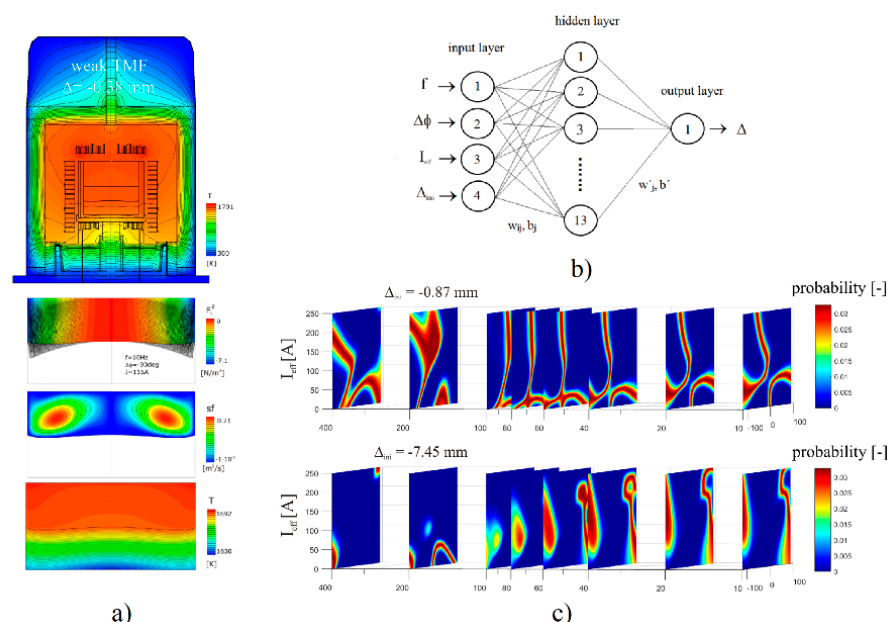
Figure 9. Optimization of magnetic parameters in magnetically driven DS-Si using feed-forward ANN / GP: ( a ) CFD and magnetic simulation results for generation of database, ( b ) ANN architecture, ( c ) probability distribution of fulfilling the condition | ∆ | < 0.1 mm as a function of Travelling magnetic field’s (TMF) magnetic parameters. Reprinted from [29] with permission from Elsevier.